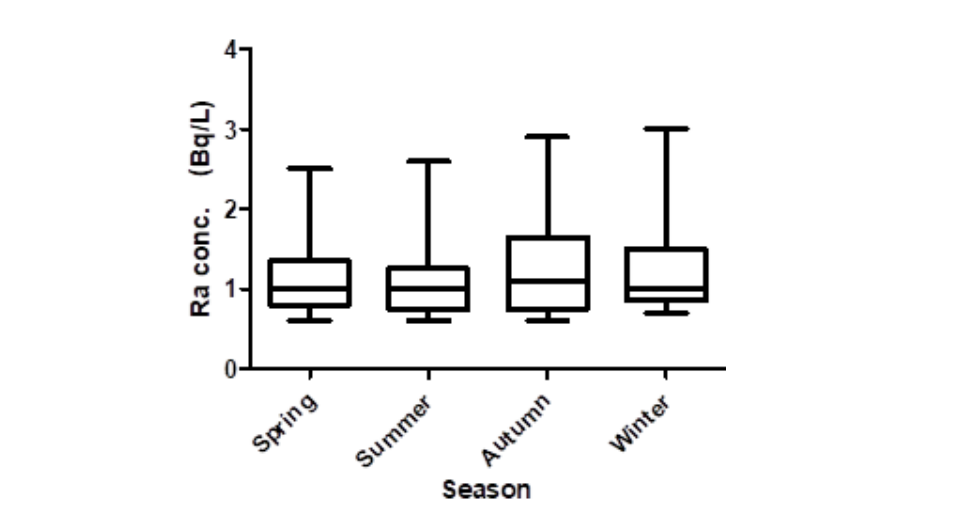
Figure 3. Seasonal (season) distribution of radon activity concentration (Bq/L) in 29 Romanian karstic springs surveyed during 2019–2020.